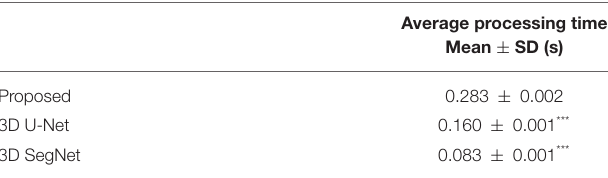
TABLE 3 | Comparison of the proposed method with four segmentation methods in the case of a GGO nodule.